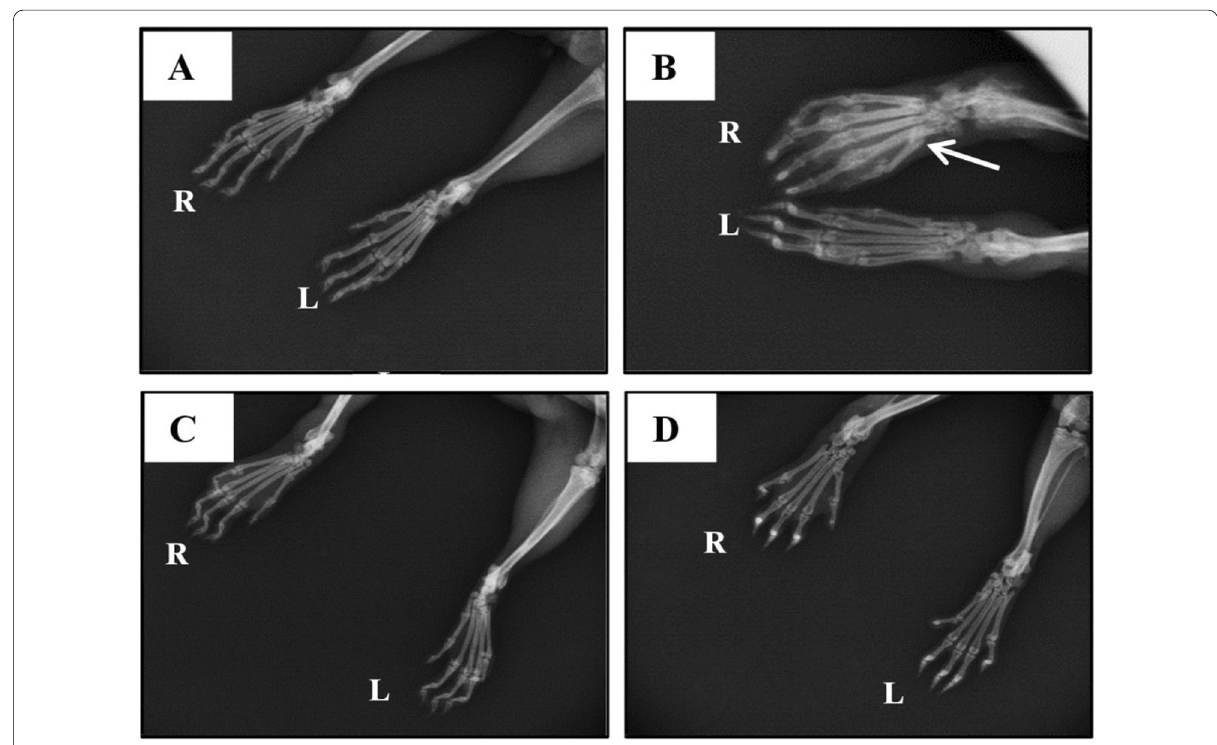
Fig. 5 X-ray radiographic of tarsotibial joints of hind legs from different animal groups. A Control rats show a normal structure of joint; B CFA-induced arthritic rats show swelling of soft tissue on left hind paw (arrow), joint destruction, bone erosion and deformities; C prednisolone-treated group D and dry latex of C . procera -treated group show less soft tissue swelling, reduced bone destruction with normal space